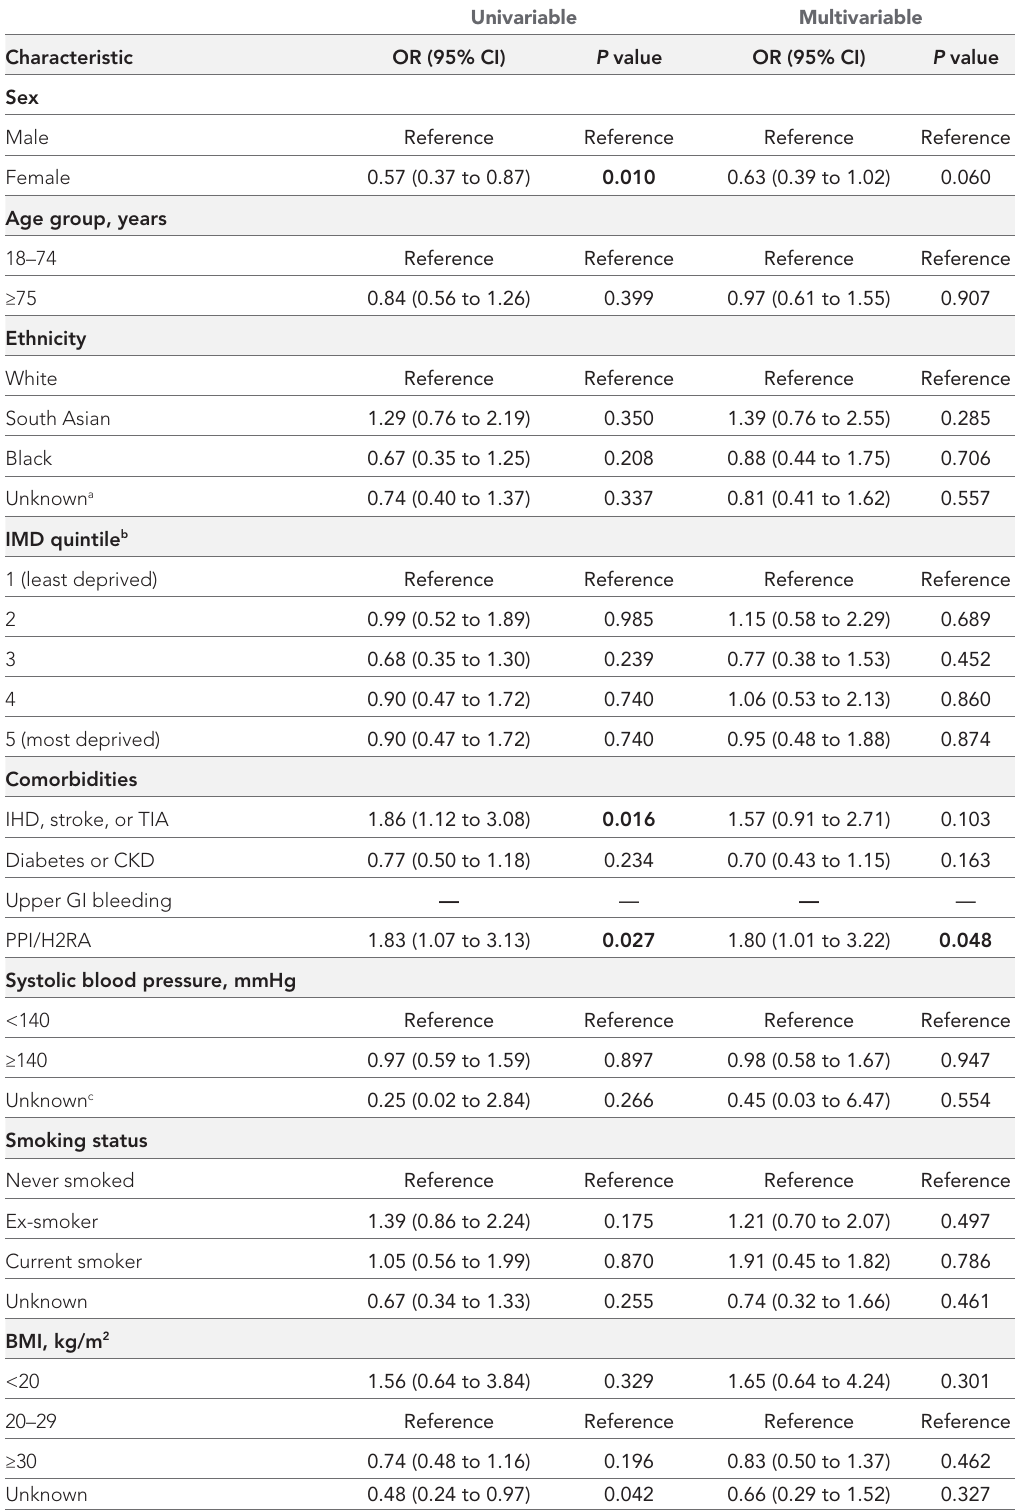
Table 3 Logistic regression models estimating the association of patient- related factors associated with DAT duration >12 months (versus <6 months) in individuals with AF Univariable Multivariable Characteristic OR (95%